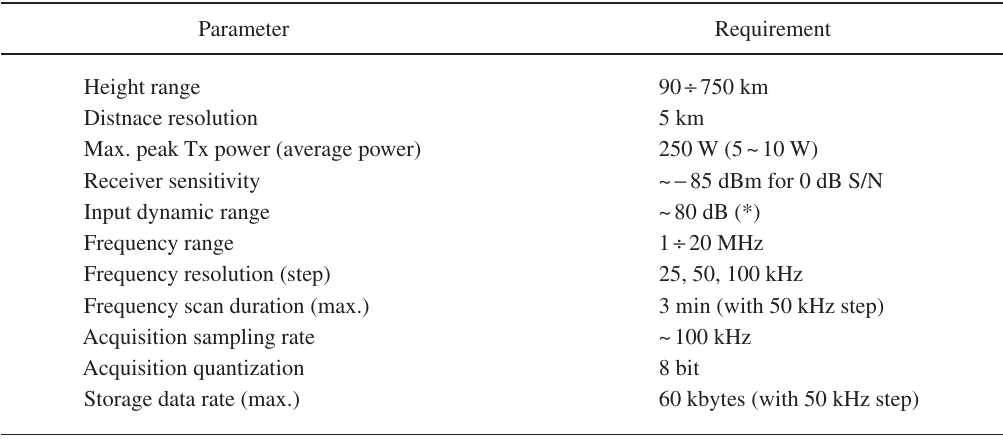
The symbol (*) indicates the maximum range of input received powers, in all possible conditions; it is not required that the system maintains the linearity over it, provided that it allows the recognition of the echo